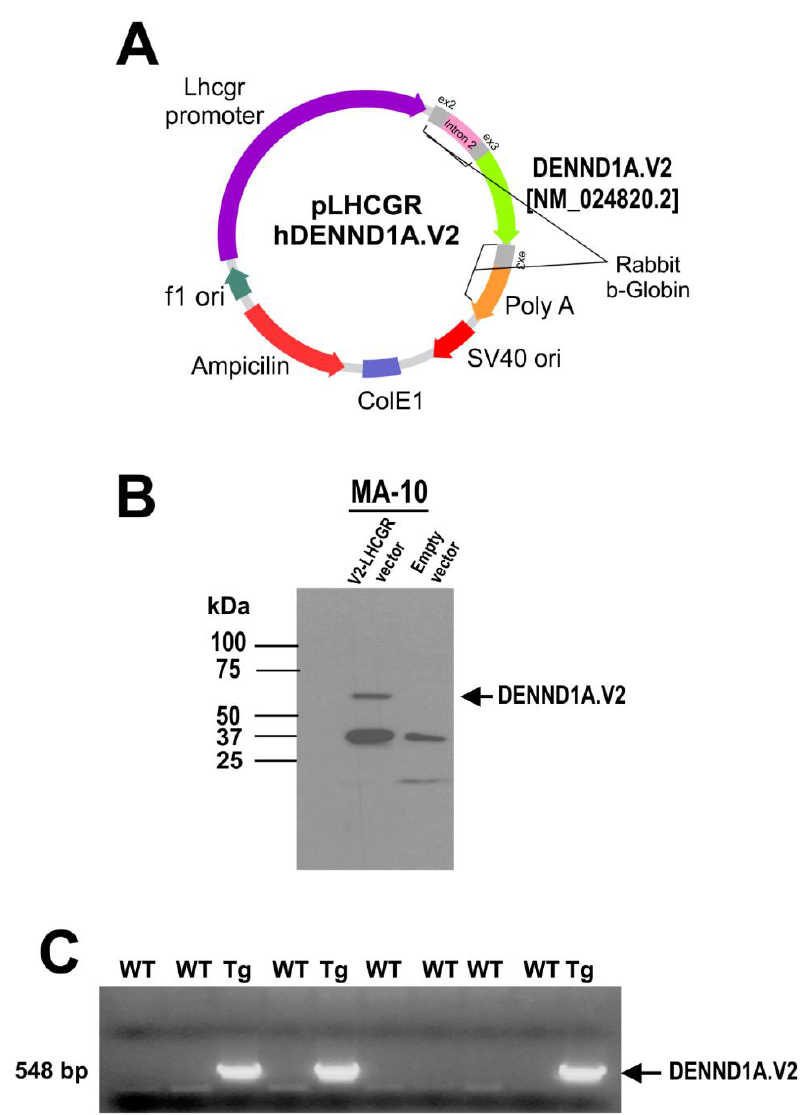
Figure 7. The p Lhcgr -hDENND1A.V2 expression construct. ( A ) Map of the p Lhcgr -hDENND1A.V2 construct (not drawn to scale). ( B ) Efficiency of the construct was tested by Western blot in transfected MA-10 cells using an anti-hDENND1A.V2 rabbit antibody. ( C ) Representative PCR results for the genotyping of wild-type and transgenic mice generated using the p Lhcgr -hDENND1A.V2 vector. WT, wild-type; Tg, transgenic; V2. Lhcgr , p Lhcgr -hDENND1A.V2 vector.